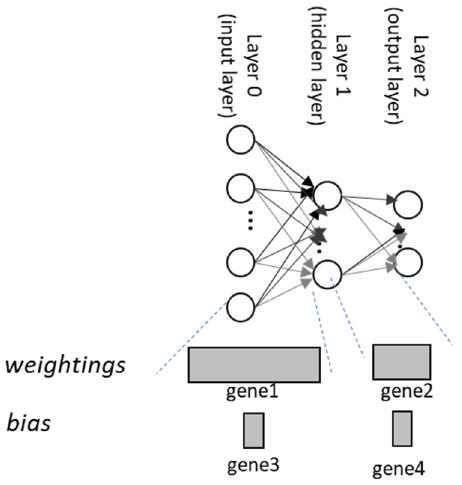
Figure 11. The definition of the chromosomes in GA.